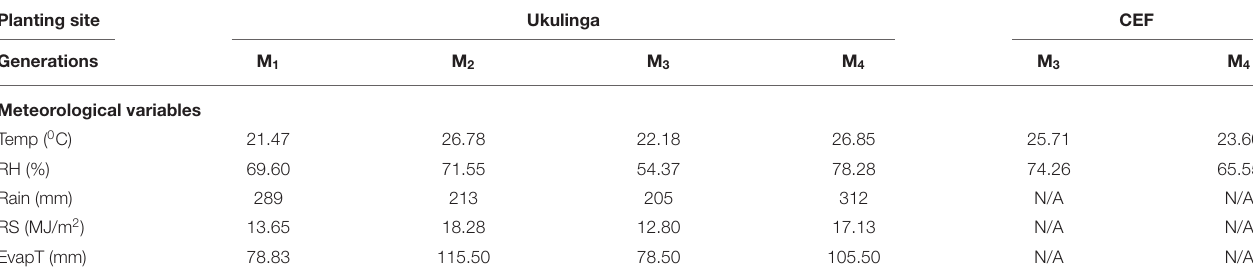
TABLE 1 | Meteorological data recorded at the study sites during evaluation of the M 1 to M 4 generations of wheat. Planting site